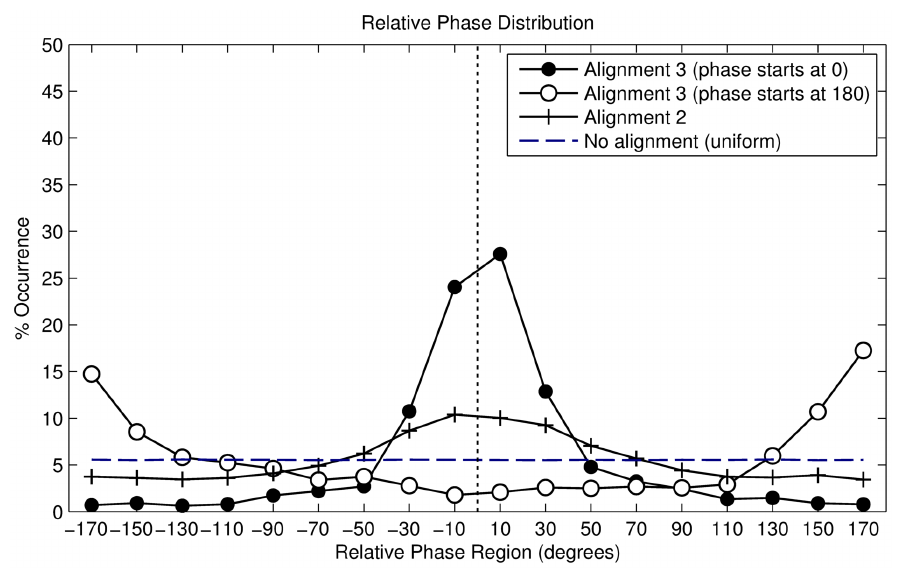
Fig. 10. Angular histogram of alignment strategy 3 (period-adaptive